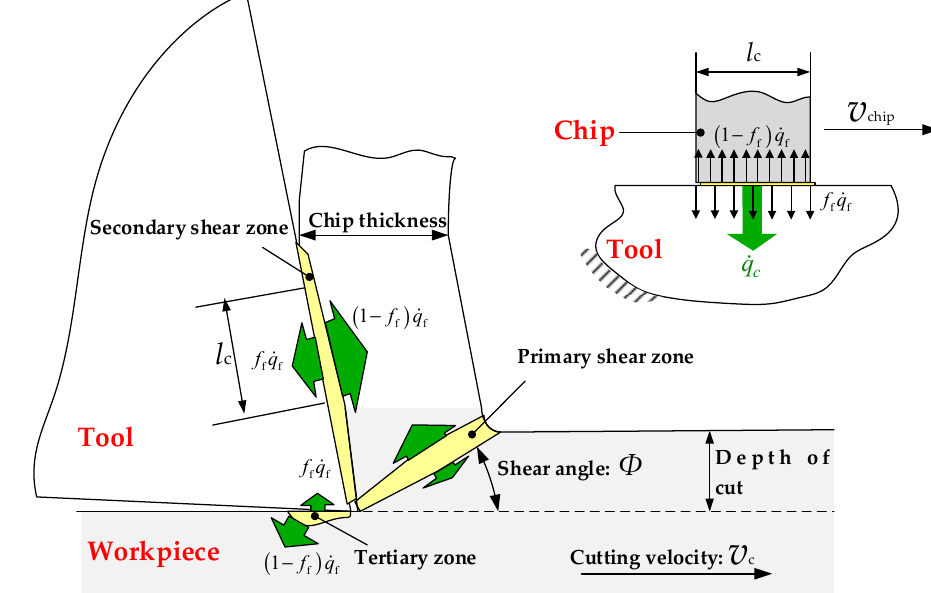
Figure 9. Schematic of heat partitioning in the chip formation process.